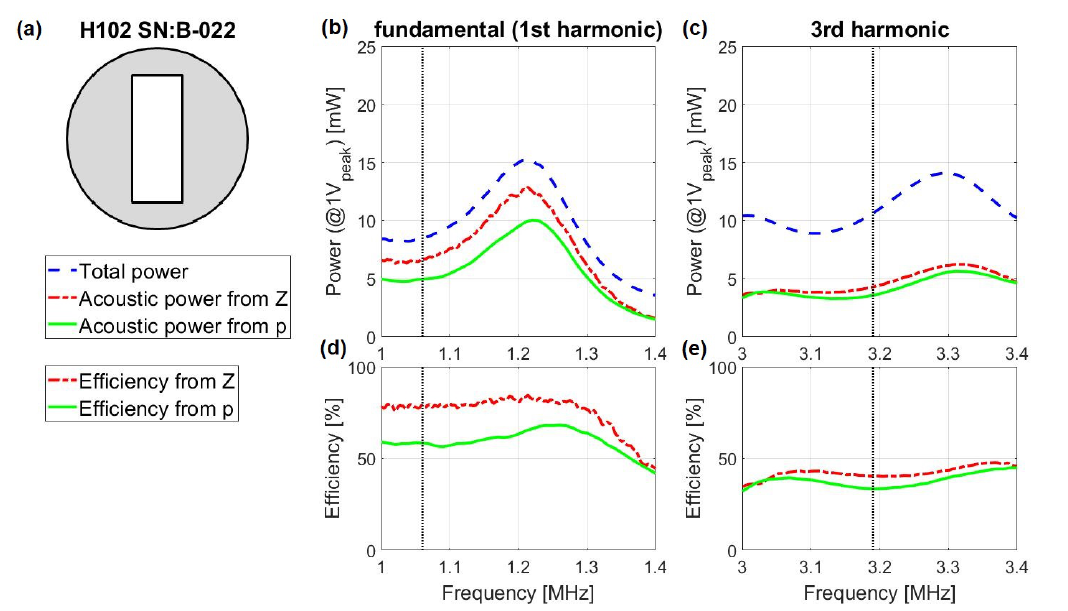
Figure 4. Comparison of electrically estimated (from impedance “Z” measurements) and acoustically measured (estimated from acoustic pressure “p” field measurements) power outputs (1 V peak drive voltage) of the H-102 (SN: B-022) transducer. ( a ): Transducer surface schematic with the cutout. ( b , c ): Total (electric and acoustic) power and estimated and measured acoustic power. ( d , e ): Estimated and measured efficiency. The dotted vertical lines indicate the centre frequency defined by the manufacturer at the fundamental and third harmonic resonances of the transducer.